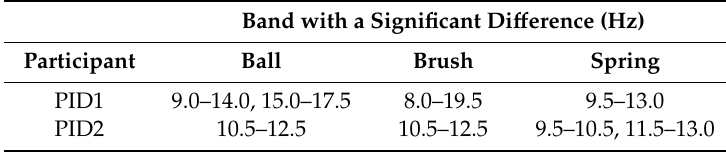
Table 3. The bands in which significant di ff erences were found around 8–20 Hz ( p <